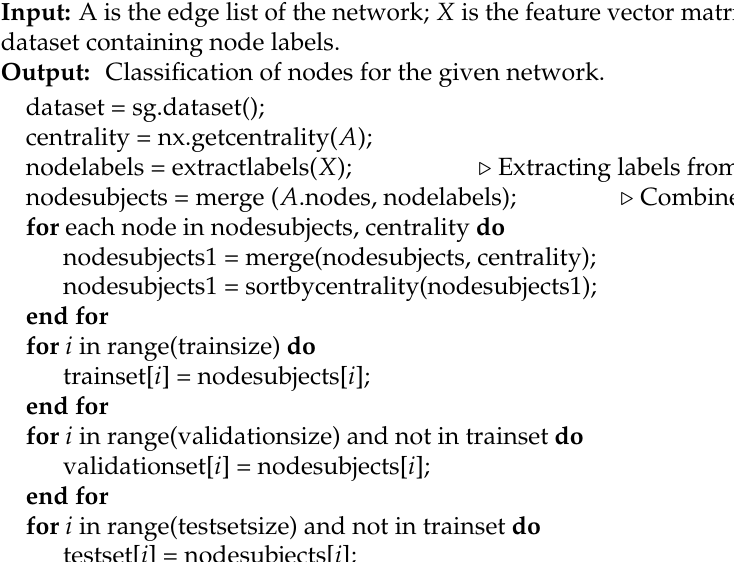
Algorithm 1 Pseudocode of Bet-GAT(A,